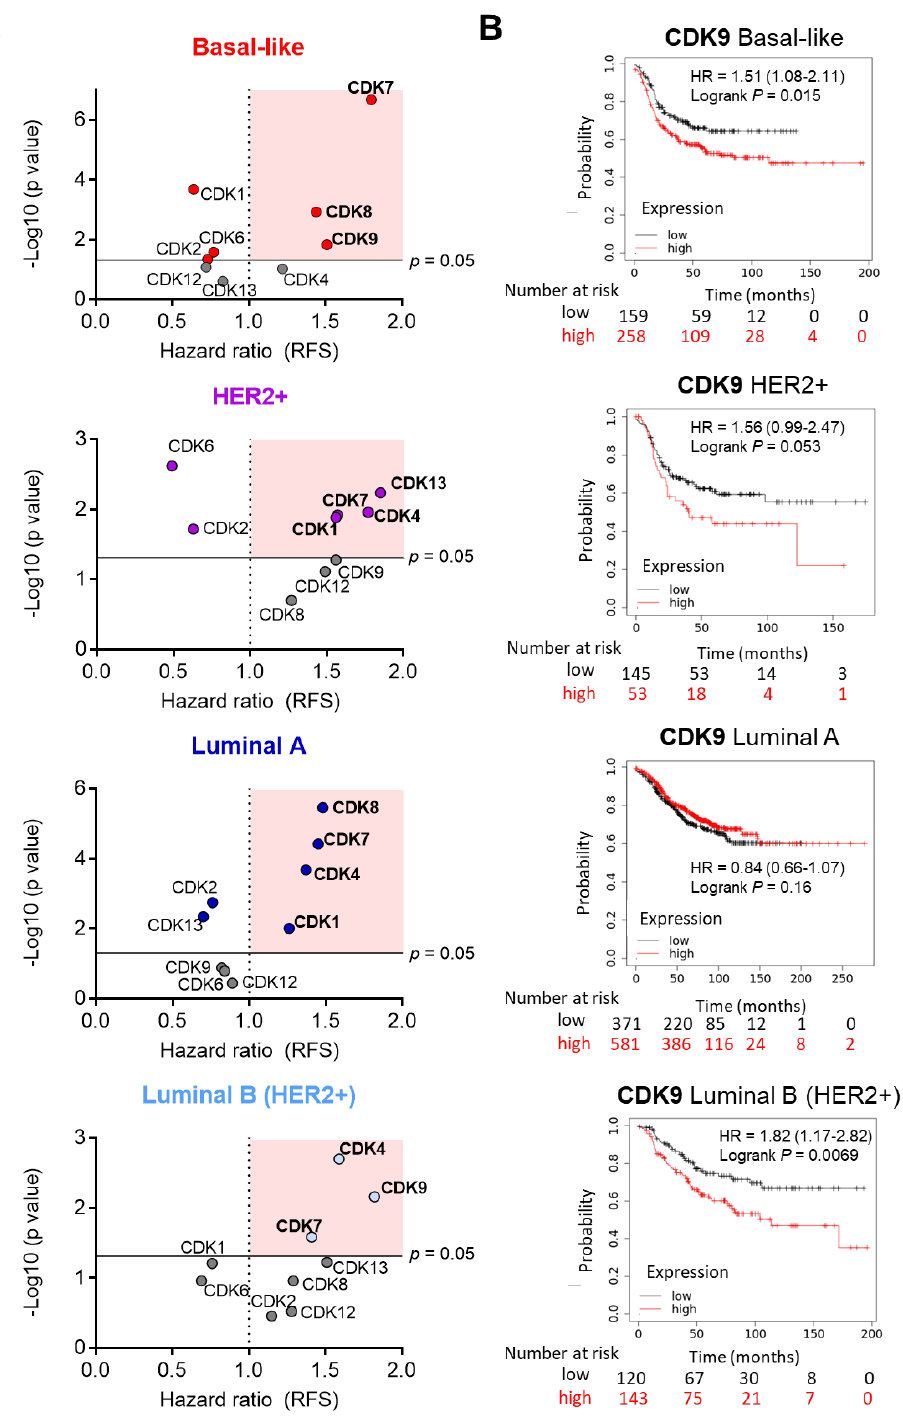
Figure 1. Correlation between CDKs expression level and clinical outcome in breast cancer. Graphs displaying HR values and p -value derived from the logrank test extracted from Kaplan–Meier survival plots of the association between CDKs individually expressed and patient prognosis, in- cluding relapse-free survival (RFS), for breast subtypes: basal-like ( n = 417), Luminal A ( n = 952), HER2+ ( n = 198), and Luminal B with Status HER2+ ( n = 263). CDKs with a significantly detrimental outcome association are included in highlighted square ( A ). Kaplan–Meier survival plots of the asso- ciation between CDK9 mean expression levels and patient prognosis, including relapse-free survival (RFS) ( n = 1764) for all breast subtypes: basal-like ( n = 417), Luminal A ( n = 952), HER2+ ( n = 198), and Luminal B with Status HER2+ ( n = 263) ( B